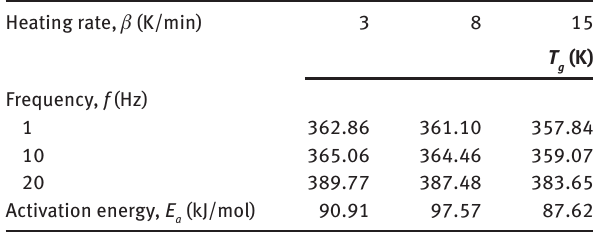
and E for pure epoxy. g a